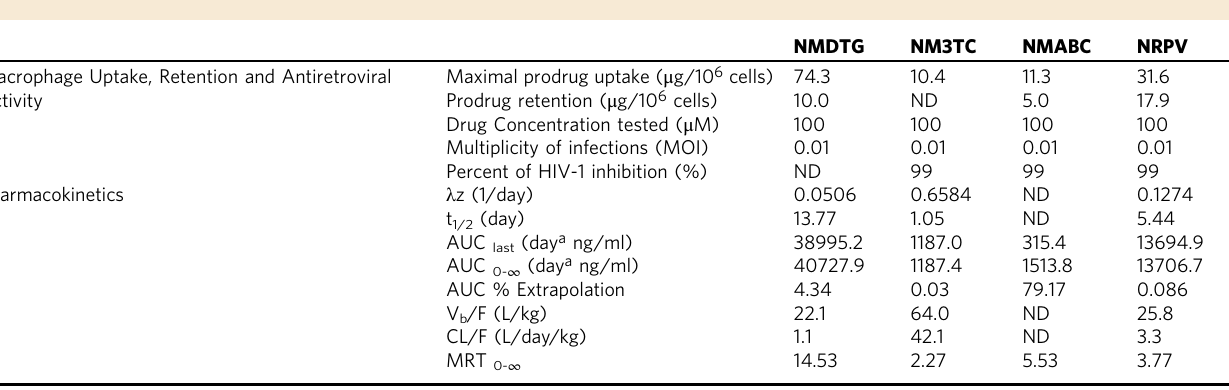
Table 1 Cell and animal PK data sets for the LASER ART nanoformulations